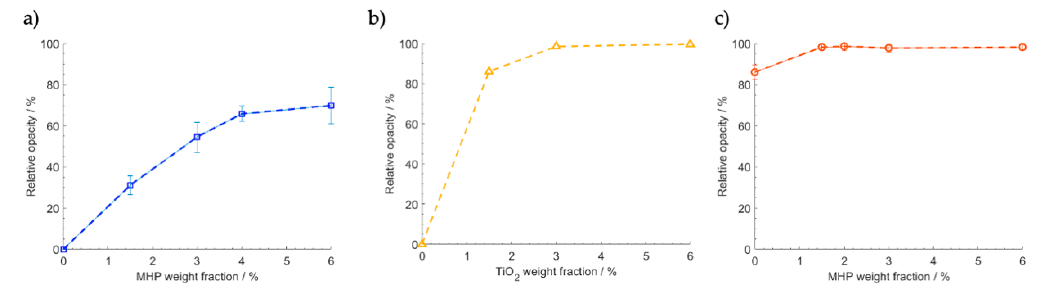
Figure 6. Relative opacity of LDPE as a function of: ( a ) MHP weight fraction, ( b ) TiO 2 weight fraction, ( c ) MHP weight fraction, with 1.5 wt.% TiO 2 loading.